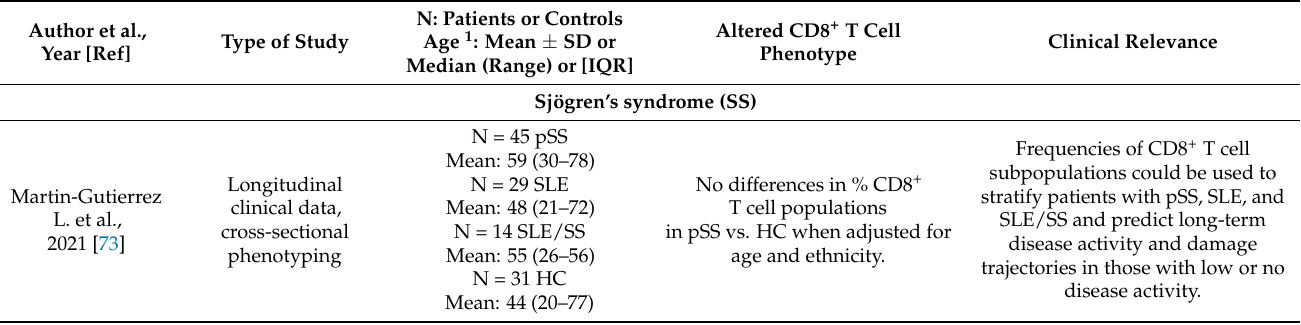
Table 3. Altered peripheral blood CD8 + T cell phenotype in adults with connective tissue